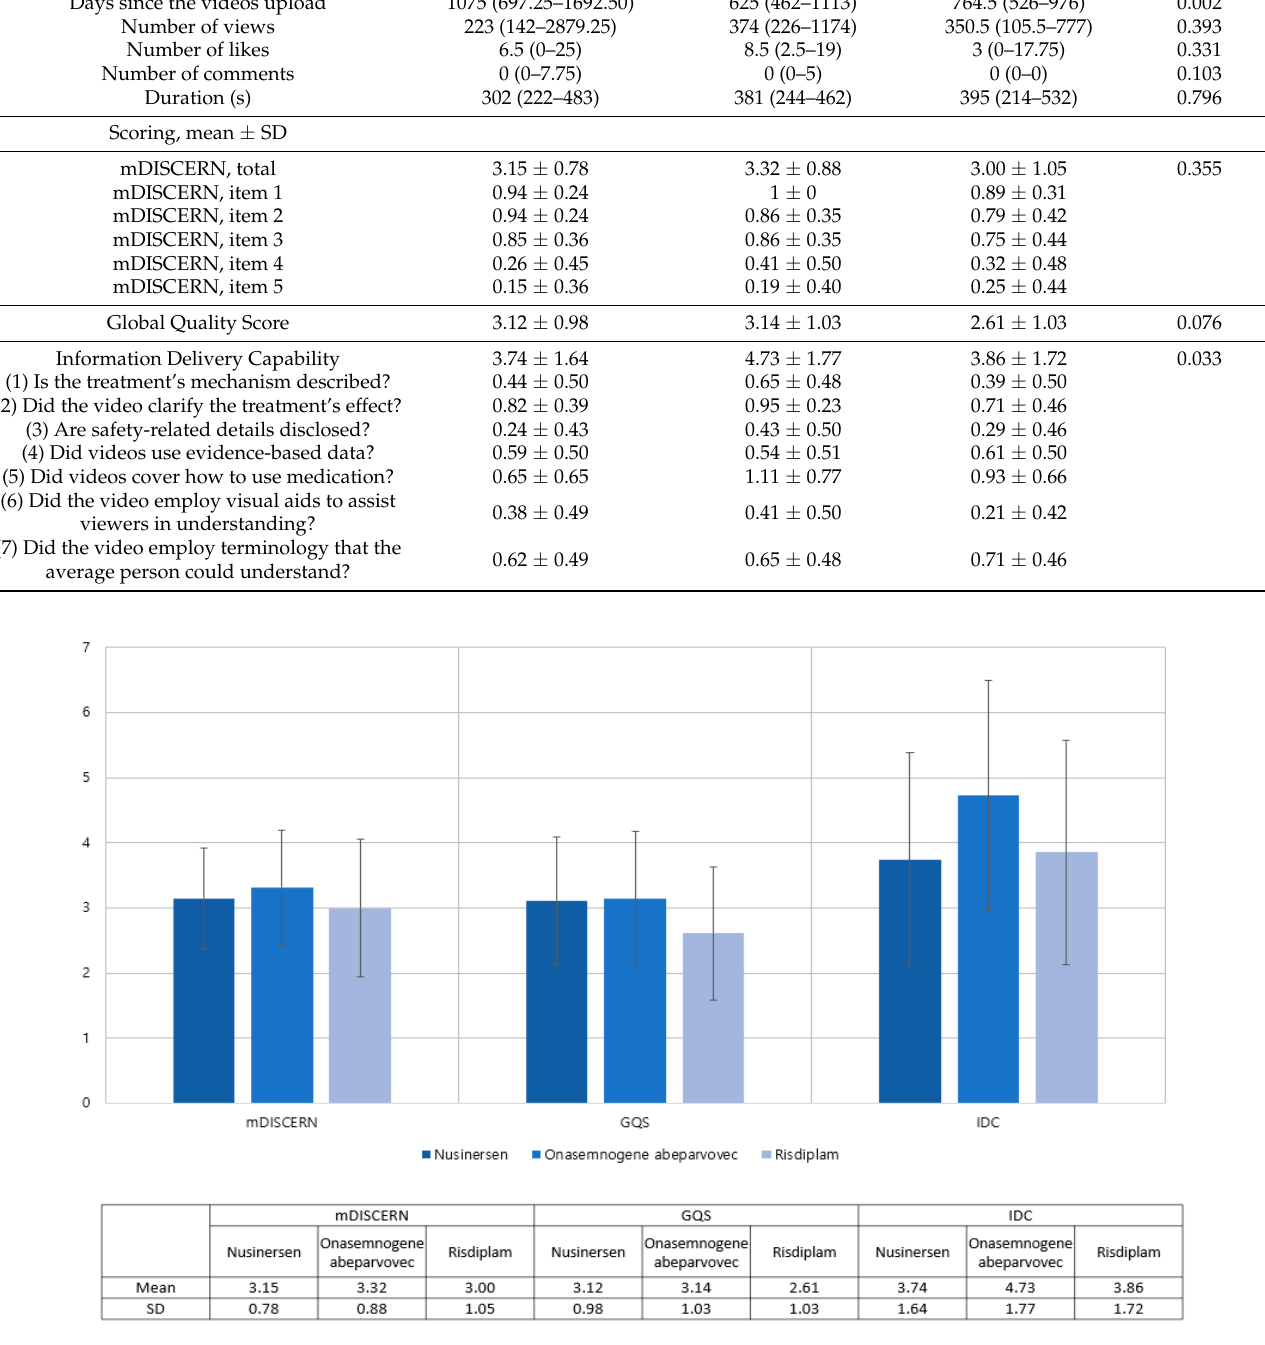
Table 3. Characteristics of the videos according to a subgroup (expertise of lecturer and educational methods).